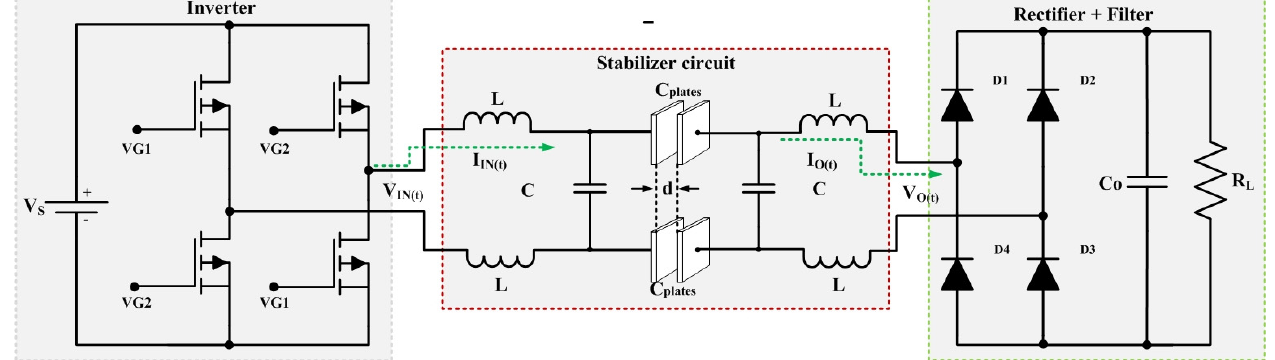
Figure 1. Circuit with capacitive power transfer.